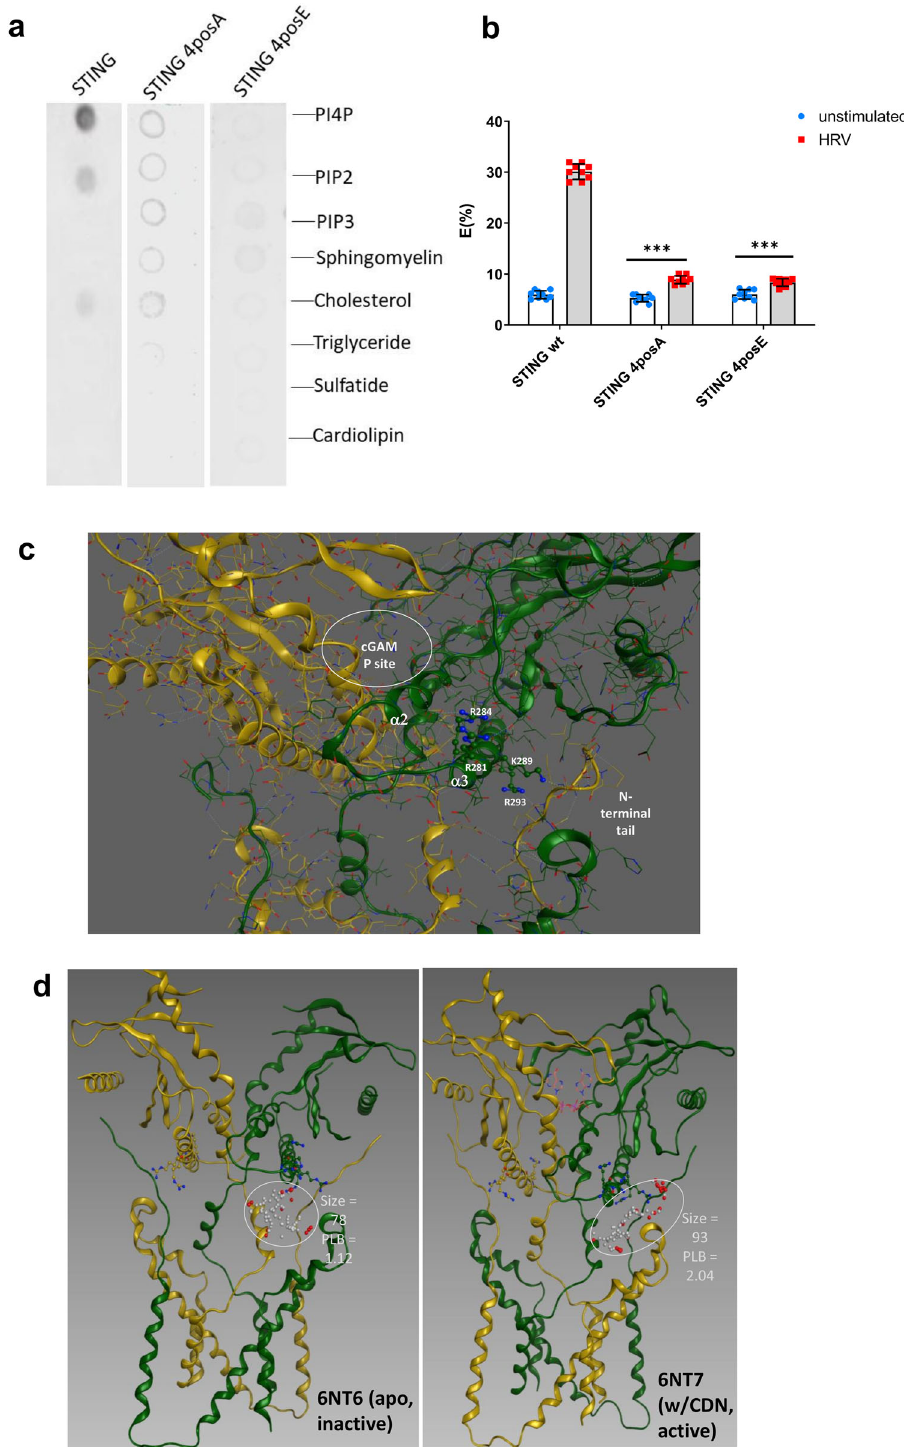
Fig. 6 STING interacts with PI4P via a patch of positive charged amino acids. Recombinant STING or puri fi ed STING 4posA or STING 4posE were incubated with a PIP strip expressing different phospholipids and binding was revealed by anti-STING antibody followed by the appropriate secondary antibody and visualisation ( a ). ( n = 3 independent experiments, representative western blot shown). Huh7.0 wildtype, STING 4posA, or STING 4posE cells were infected with HRV for 4 h before FRET ef fi ciency (E%) assessment for STING and PI4P. Data are means + / − SD ( n = 3, independent experiments). *** p < 0.001 indicate statistically signi fi cant ( b ). MOE Site fi nder alpha spheres indicate space for large ligand binding partners; residues comprising charged patch circled; alpha spheres: white (near hydrophobic residues) and red (near hydrophilic residues) ( c ); comparison of the charged patches in inactive (right) or active (left) STING ( d